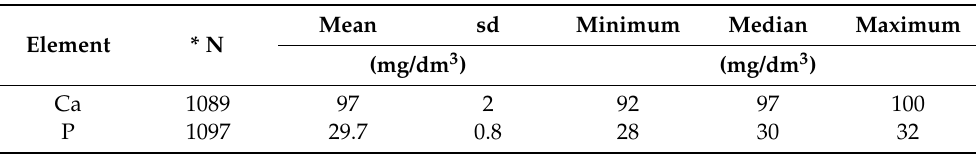
Table 2. The basic characteristics of the datasets obtained via the measurement of calcium and phosphorus with the ICP OES